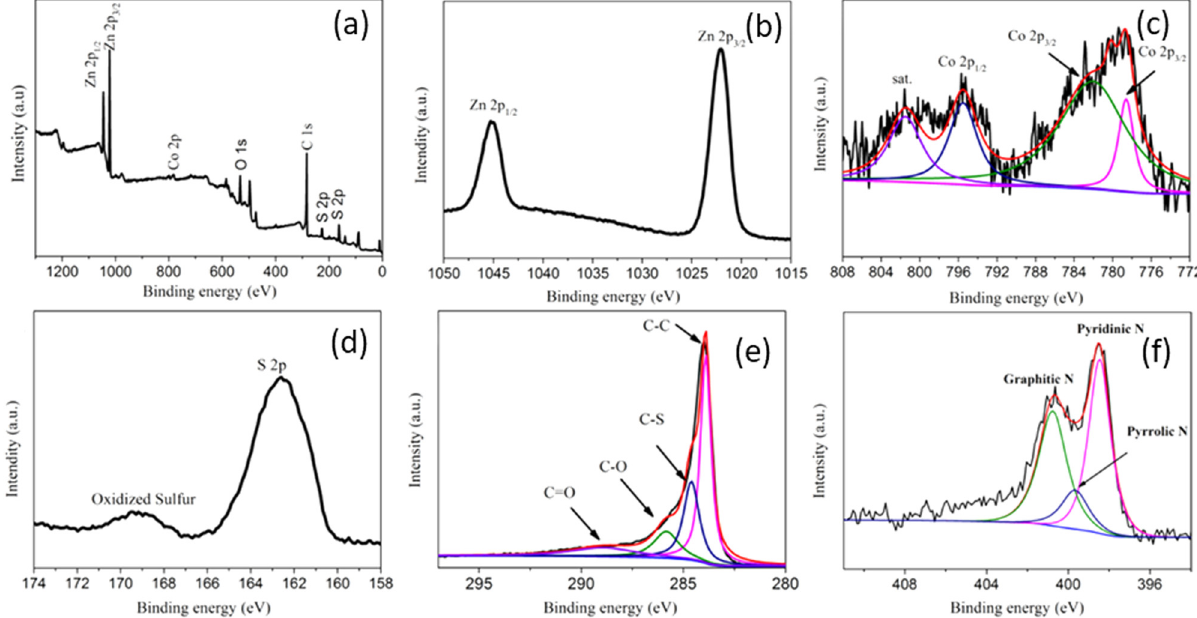
Figure 4: XPS spectra of the as - synthesized Zn 0.76 Co 0.24 S@N/S - rGO: ( a ) survey, ( b ) Zn 2p, ( c ) Co 2p, ( d ) S 2p, ( e ) C 1s, and ( f ) N